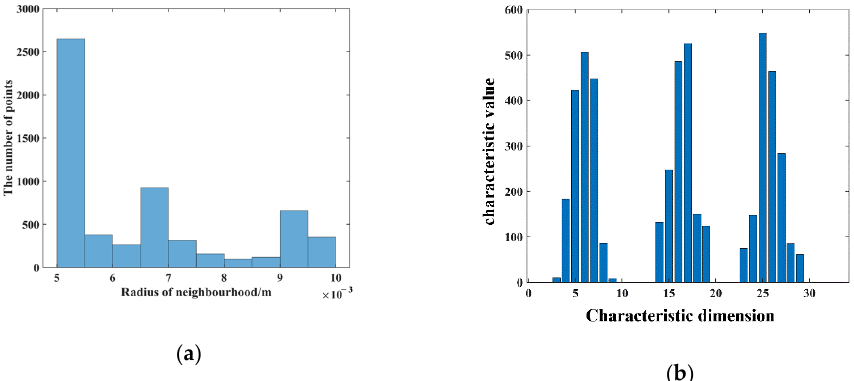
Figure 10. Processing results of source point cloud. ( a ) Adaptive optimal neighborhood distribution. ( b ) The AGWF feature descriptor.